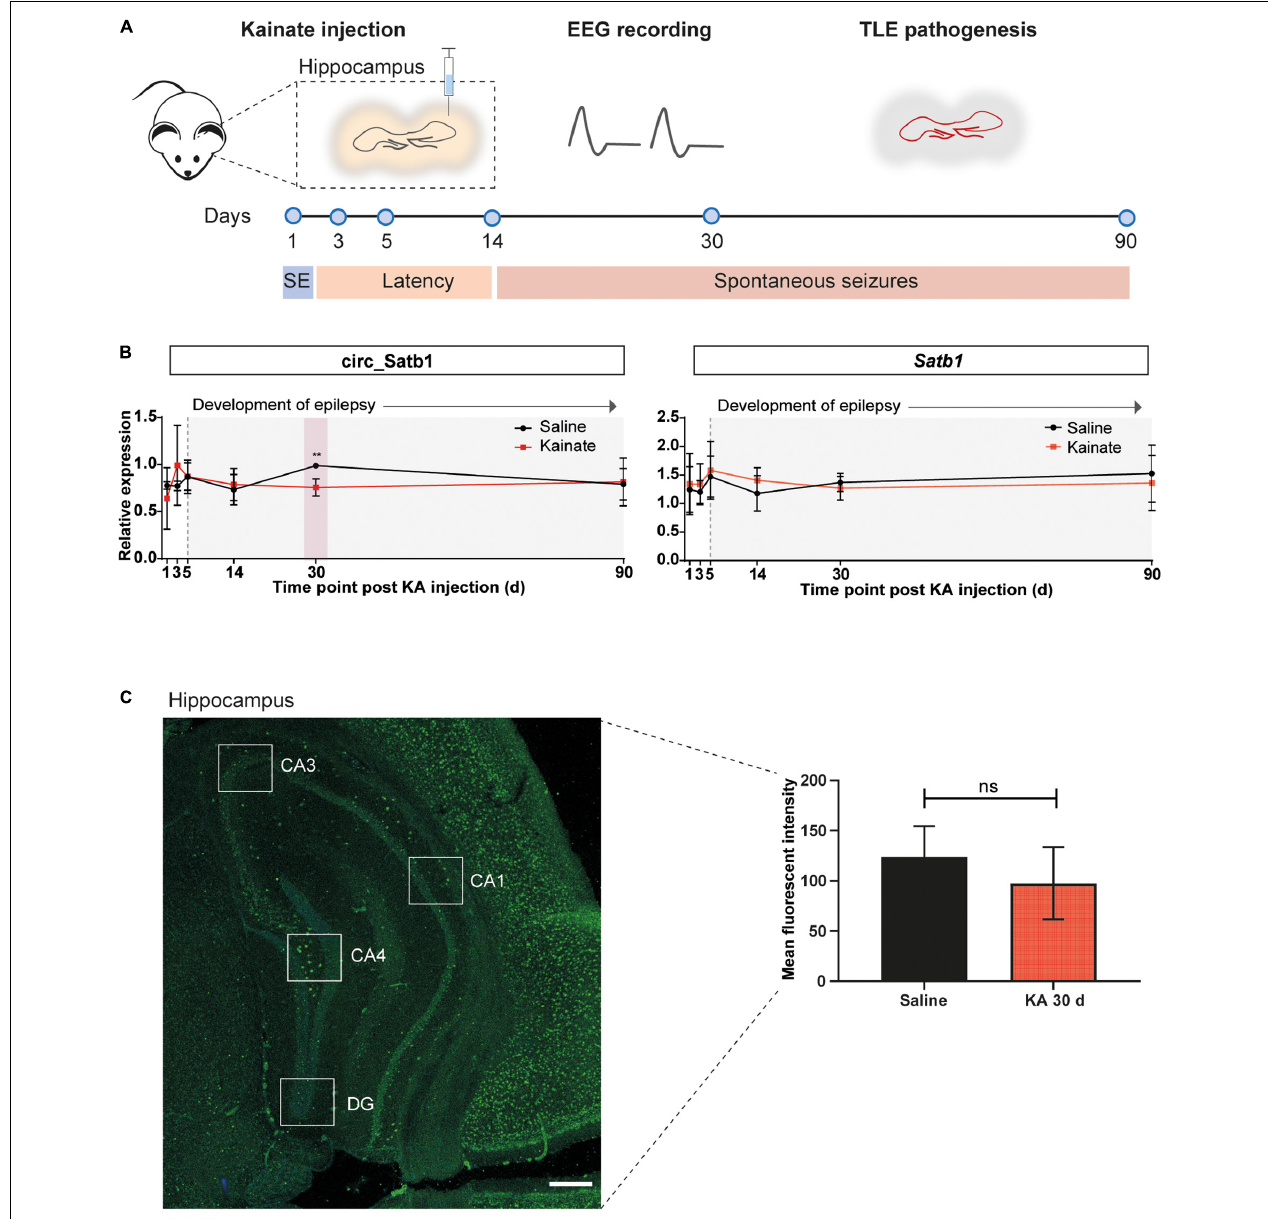
FIGURE 3 | Deregulation of circ_Satb1 in a mouse model of TLE. (A) Schematic representation of the intracortical kainate (ICK) model of TLE used in the present study. Kainate or saline were injected unilaterally into the neocortex above right dorsal hippocampus, and the animals were followed over a period of 90 days (d) with electroencephalogram (EEG) recordings. Hippocampal samples were collected at six different time points post-injection: 1 day ( status epilepticus , SE), 3 days after SE; 5 and 14 days (latent period); 30 and 90 days (chronic spontaneous seizures). (B) Satb1 /circ_Satb1 expression relative to Phosphoglycerate kinase ( Pgk ) in the ICK model of TLE at different time points (circ_Satb1 at KA 30 days, ** p = 0.0062). Dot plots represent means ± SEM. Multiple unpaired t -tests with Holm-Šídák method for multiple comparisons; n = 3–6 animals per group (KA, kainate/kainic acid; d, days). (C) SATB1 protein levels in the hippocampus of saline- and KA-injected (30 days) mice. Expression levels were calculated as the fluorescence intensity across five well-defined hippocampal regions for each animal (illustrative image, left panel). Bar plots express group mean ± SEM. Unpaired two-tailed Mann-Whitney test; n = 3 animals per group (right panel). Scale bar: 500 µ m (CA1–4, Cornu Ammonis area 1–4; DG, dentate